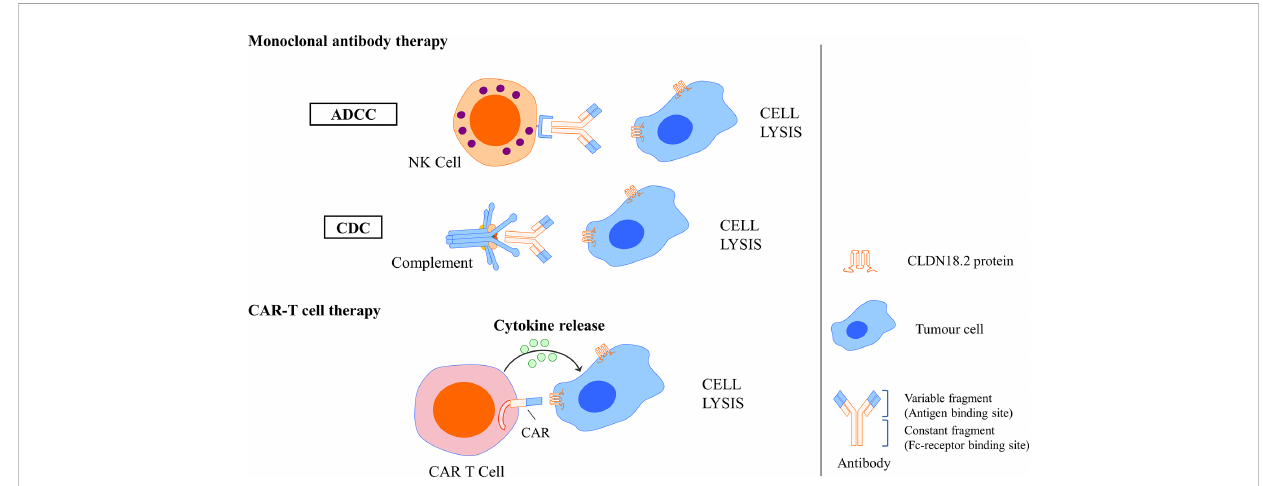
FIGURE 6 Mechanisms of CLDN18.2-targeted monoclonal antibody intervention and CAR T cell interaction. Monoclonal antibody could speci fi cally bind to CLDN18.2 expressed tumour cells and induce ADCC and CDC, resulting in the cell lysis. CLDN18.2 CAR T cell could also speci fi cally recognise CLDN18.2 expressed tumour cells and induce cytokine release, resulting in the cell